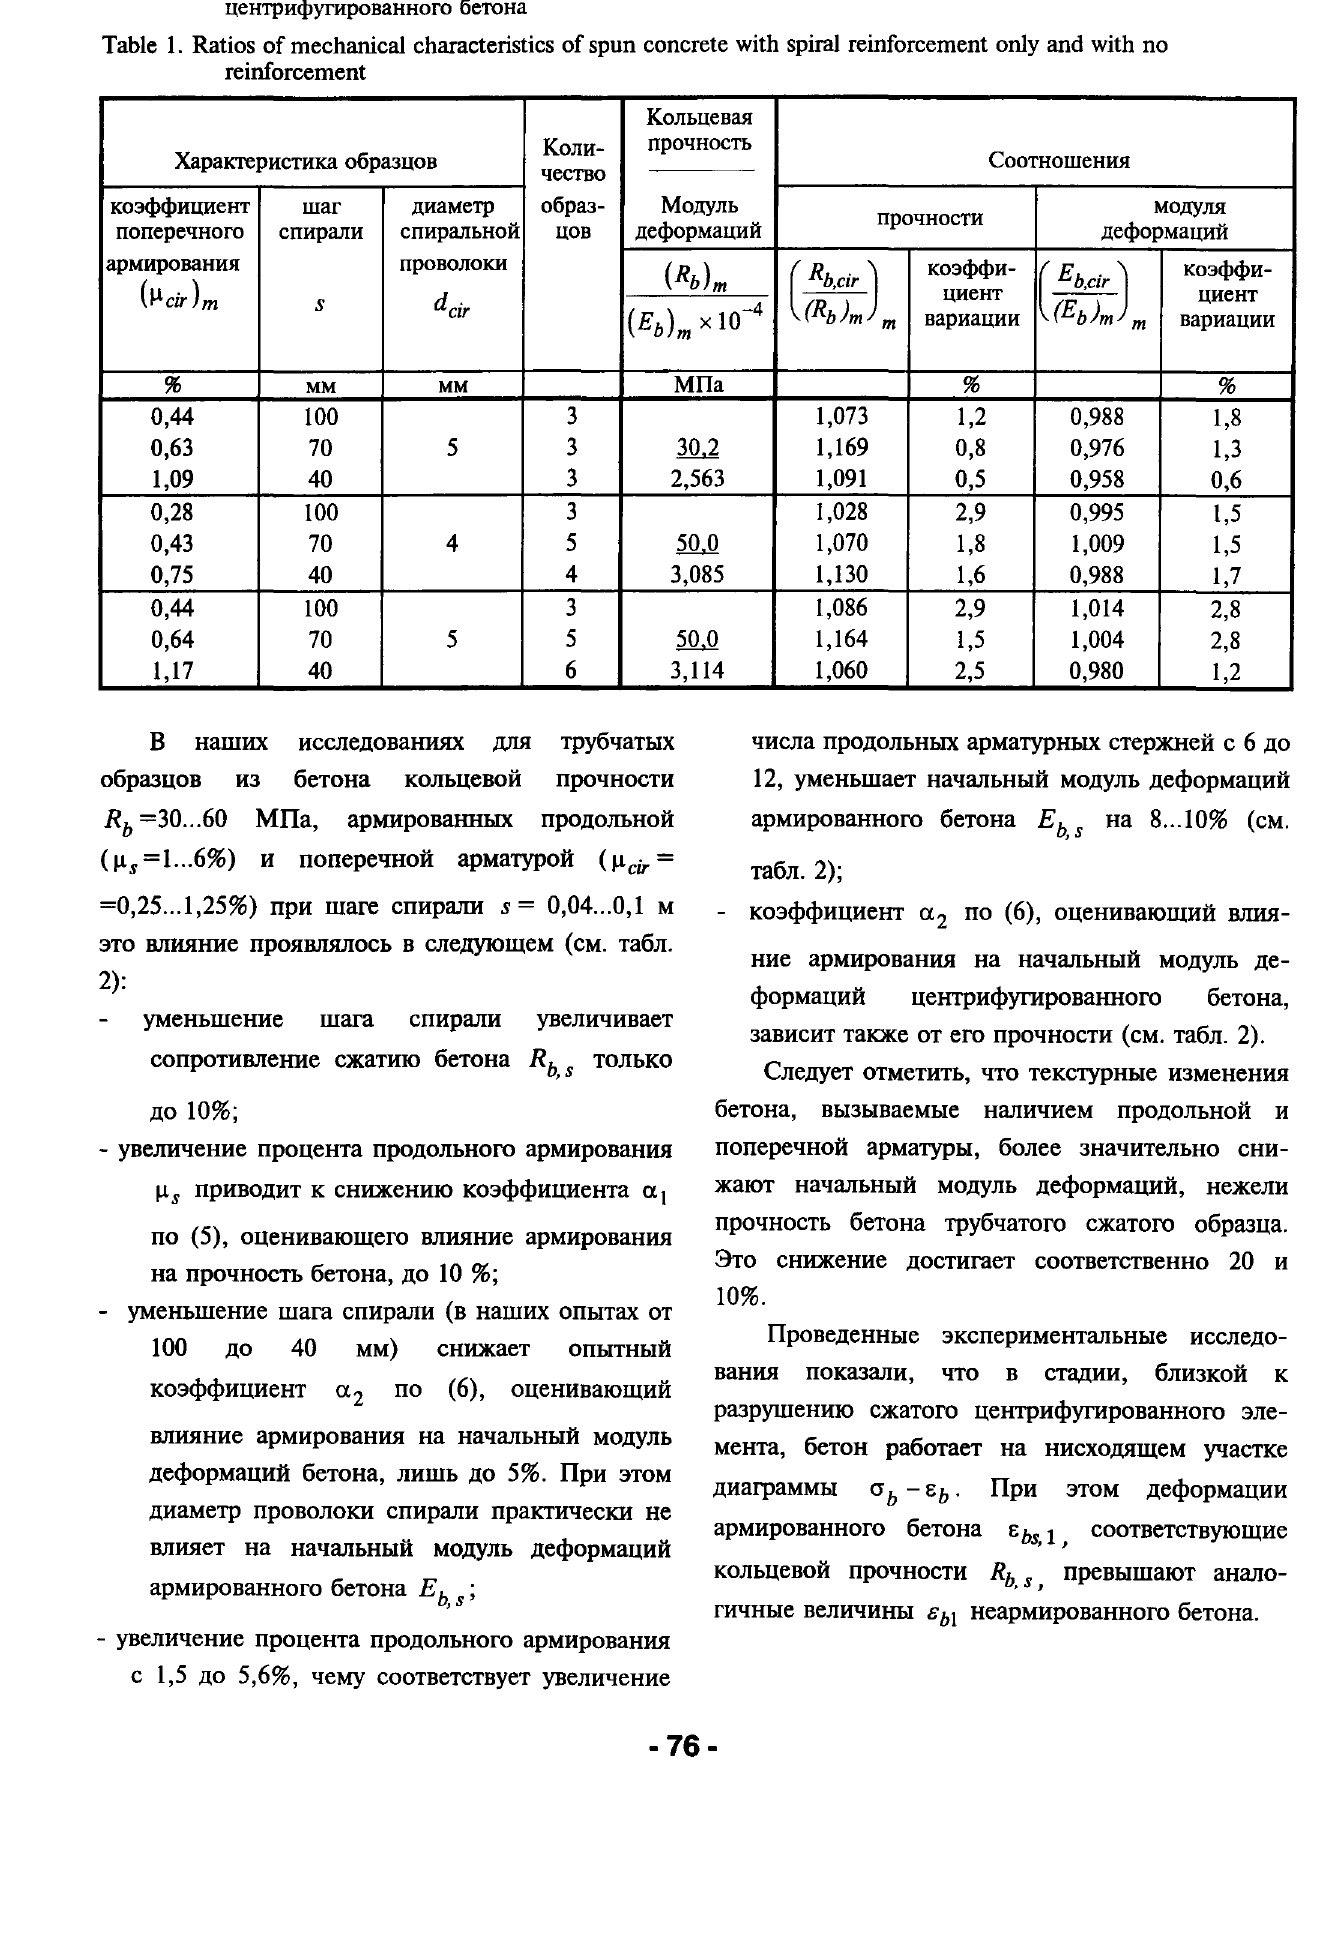
Table 1. Ratios of mechanical characteristics of spun concrete with spiral reinforcement only and with no reinforcement Kon&u;esrur XapaKTepllCTllKa o6pll3IJ;OB